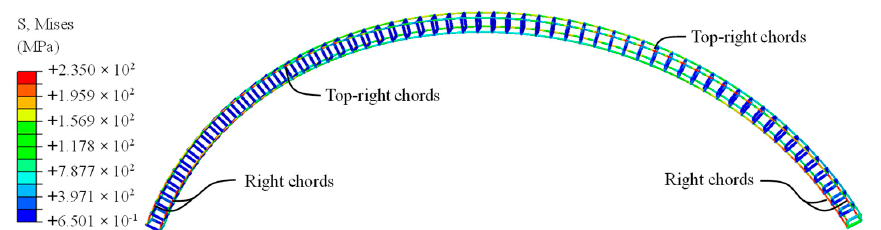
Figure 13. Stress distribution of a typical Vierendeel truss arch under the ultimate FSURL.